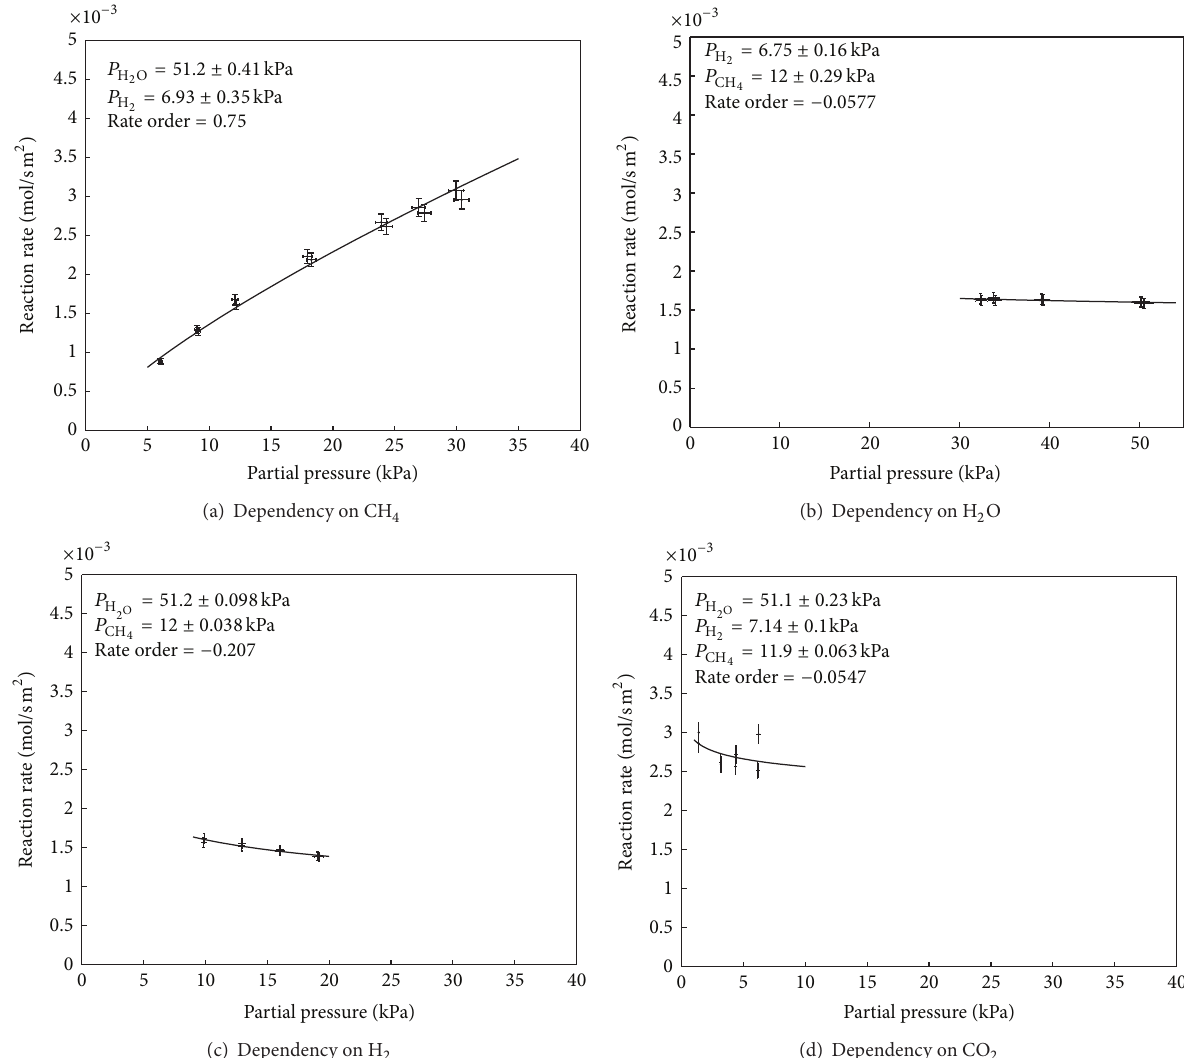
Figure 3: Reaction rate of the internal steam reforming as function of the gas concentration of CH 4 , H 2 O, H 2 , and CO 2 in a quarter cell stack at 650 ∘